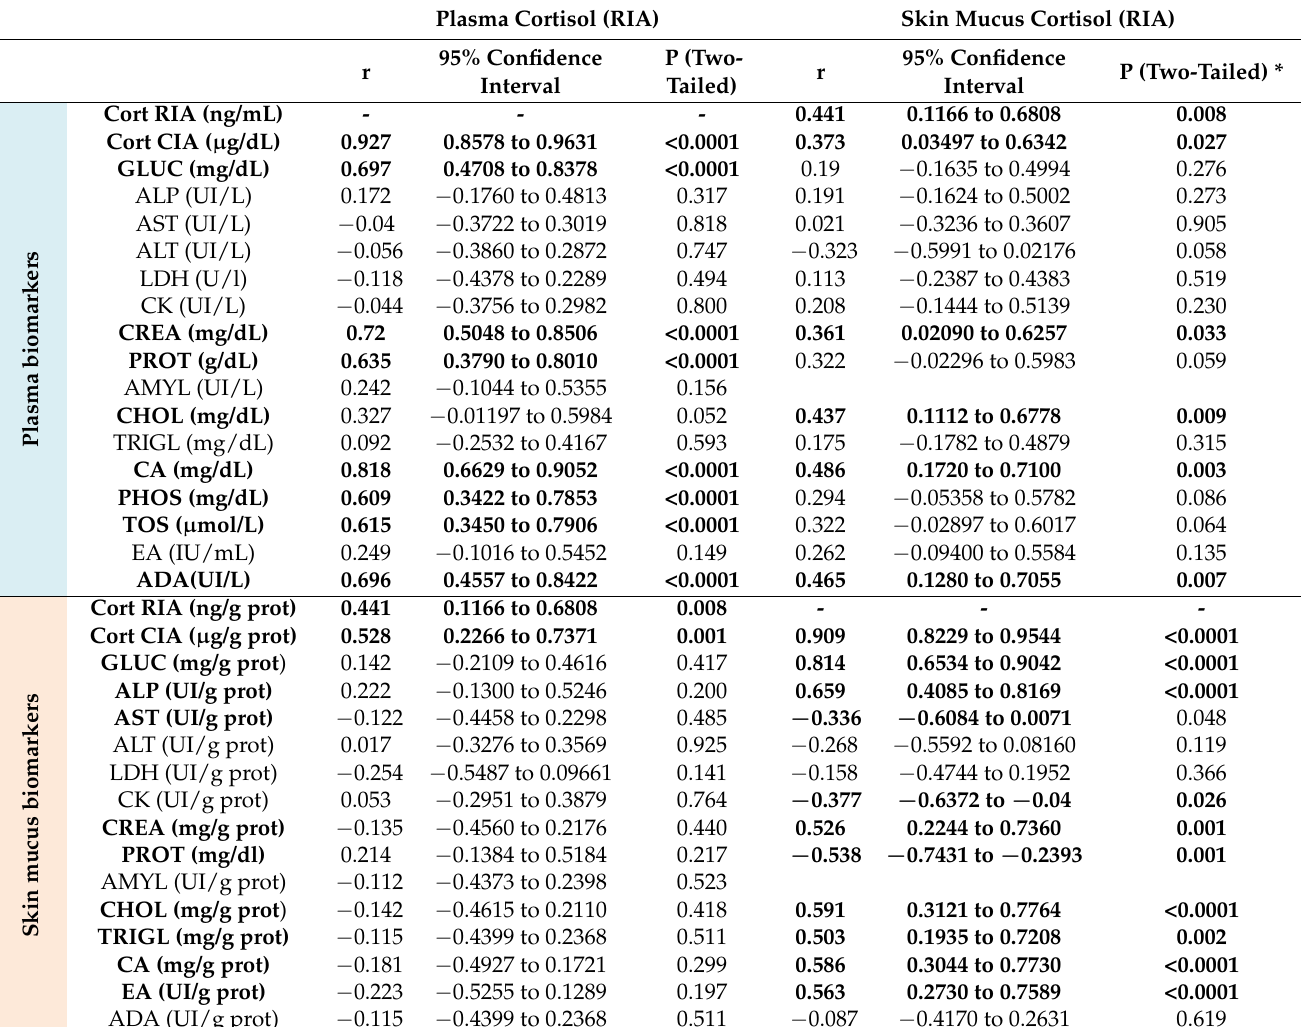
Table 1. Spearman correlation between cortisol (measured by RIA) and plasma and mucus ana- lytes. Cortisol (Cort), glucose (GLUC), alkaline phosphatase (ALP), aspartate transaminase (AST), alanine aminotransferase (ALT), lactate dehydrogenase (LDH), creatinine kinase (CK), creatinine (CREA), proteins (PROT), amylase (AMYL), cholesterol (CHOL), triglycerides (TRIGL), calcium (CA), phosphorous (PHOS), total oxidative status (TOS), esterase activity (EA), and adenosine deaminase (ADA). * In bold, statistically significant differences after applying the False Discovery Rate as per the Benjamini and Hochberg method ( p < 0.05). Plasma Cortisol (RIA) Skin Mucus Cortisol